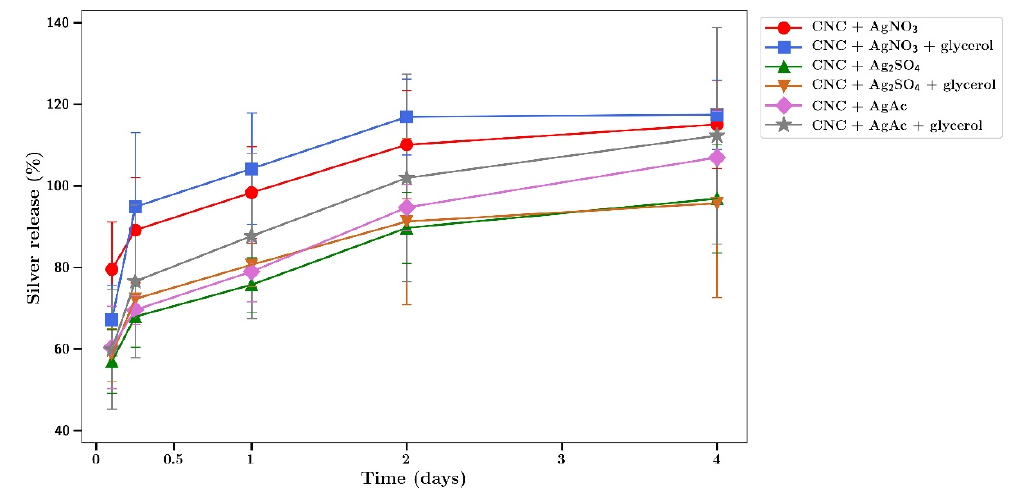
Figure 9. Time course of the release of silver from various silver salt loaded CNC hydrogels with or without glycerol in water.